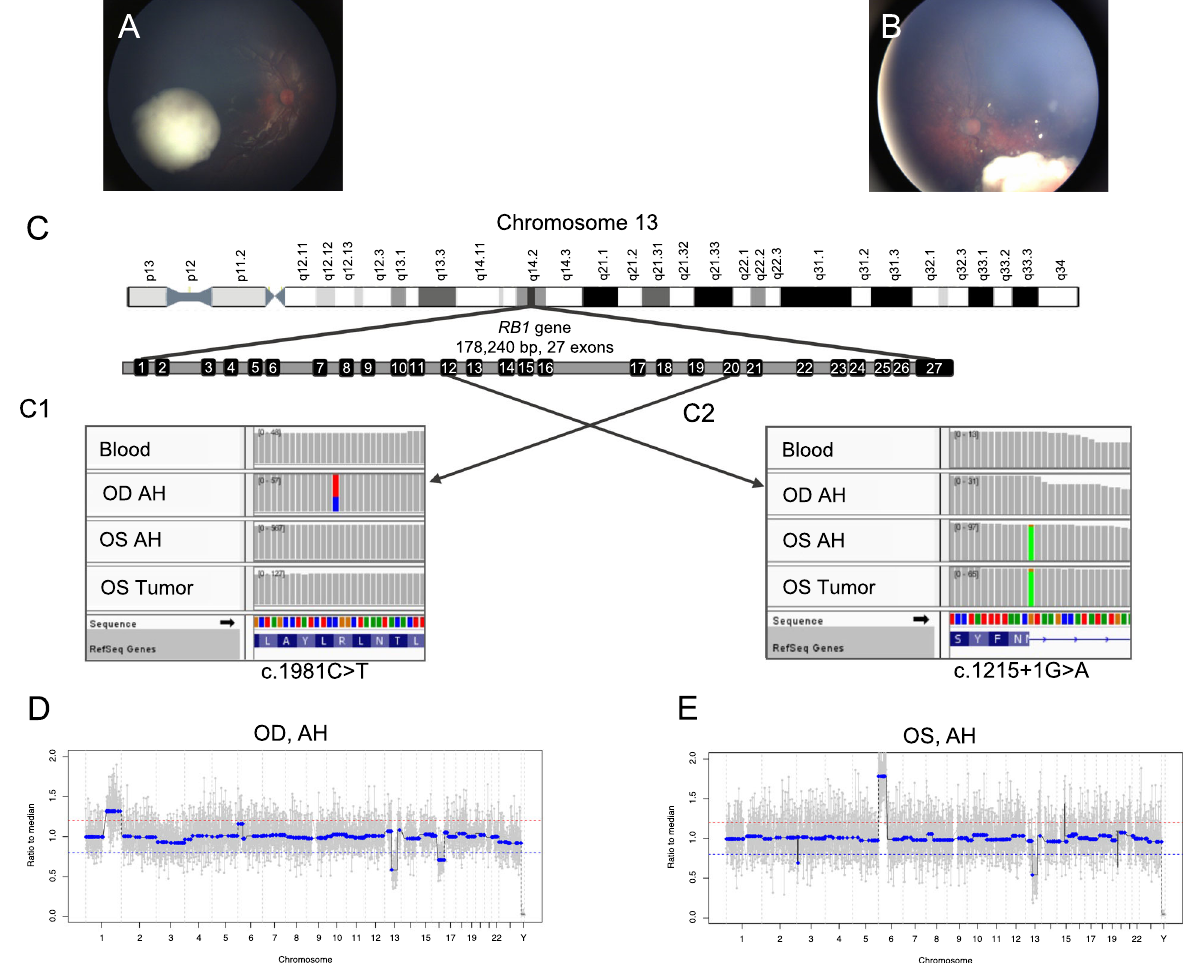
Fig. 1 Comparison of clinical images at diagnosis and genomic pro fi les between right and left eyes. A Fundus photograph of the right eye shows a cohesive, creamy white endophytic mass with predominantly scattered dust-like seeds overlying the apex and a few spherical vitreous seeds at the base of the tumor, consistent with IIRC Group C retinoblastoma. B Fundus photograph of the left eye shows a creamy white endophytic mass with intratumoral vasculature, diffuse large spherical seeds, and some dust-like seeds, consistent with IIRC Group D retinoblastoma. C Integrative genomics viewer (IGV) displays the somatic RB1 pathogenic variants in the right and left eyes. The RB1 gene is located on chromosome 13 and has 178,240 base pairs with 27 exons. Here, each vertical bar represents one base pair and gray color indicates there is no change compared with the human reference genome (hg19). C1 The right eye demonstrated a missense mutation (c.1981C>T) in exon 20, seen as the red-and-blue bar found only in the OD AH sample. This represents the second hit unique to the right eye; it is not present in the blood, OS AH, or OS tumor samples. C2 The left eye demonstrated a splice donor variant mutation (c.1215 + 1G>A) in exon 12, seen as the matching green bars in the OS AH and the OS Tumor samples. This mutation is unique to the left eye and is only seen in OS samples; it is not present in the blood or OD AH samples. The right eye ( D ) and left eye ( E ) demonstrate non-identical somatic copy number alteration (SCNA) pro fi les. The right eye demonstrated 1q gain, 13q loss (germline), and 16q loss. The left eye demonstrated 6p gain and 13q loss (germline). Of note, the 6p peak amplitude seen in the right eye remains below the 20% de fl ection threshold (represented by the red line) to be considered a true